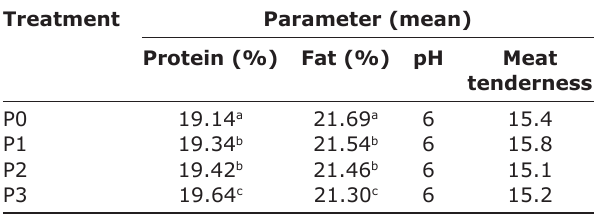
Table-1: Percentage change in parameter according to treatment for each